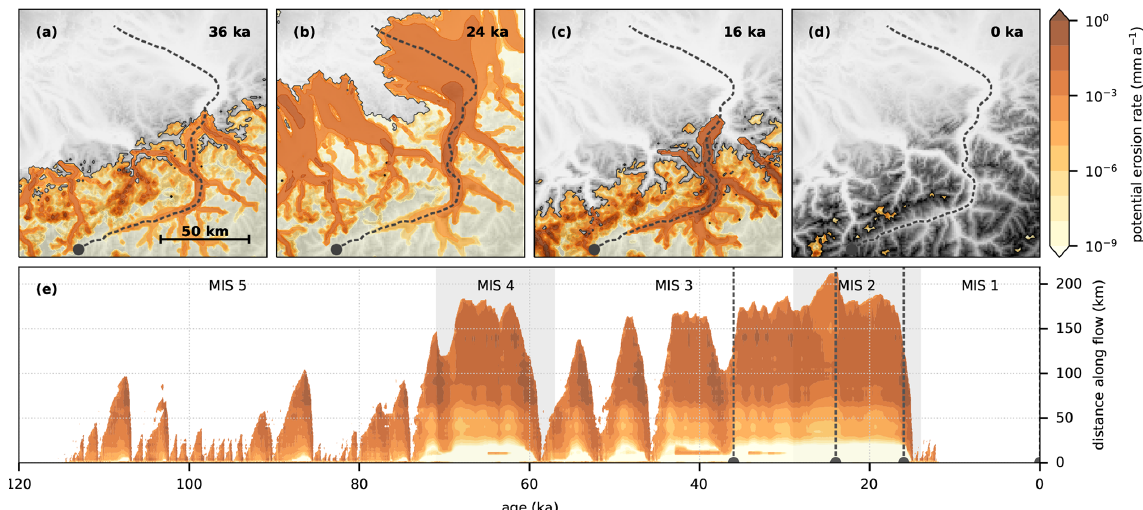
Figure 3. (a–d) Modelled instantaneous potential erosion rate of Rhine Glacier for selected glacier advance and retreat ages and the final model state for topographic reference. (e) Interpolated instantaneous potential erosion rate along a Rhine Glacier transect (upper panels, dashed line) for the entire last glacial cycle.